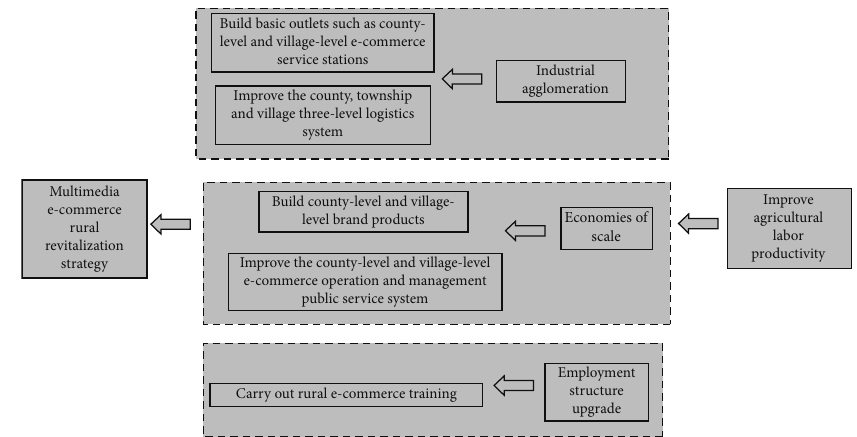
Figure 2: Flowchart of rural upgrading of multimedia